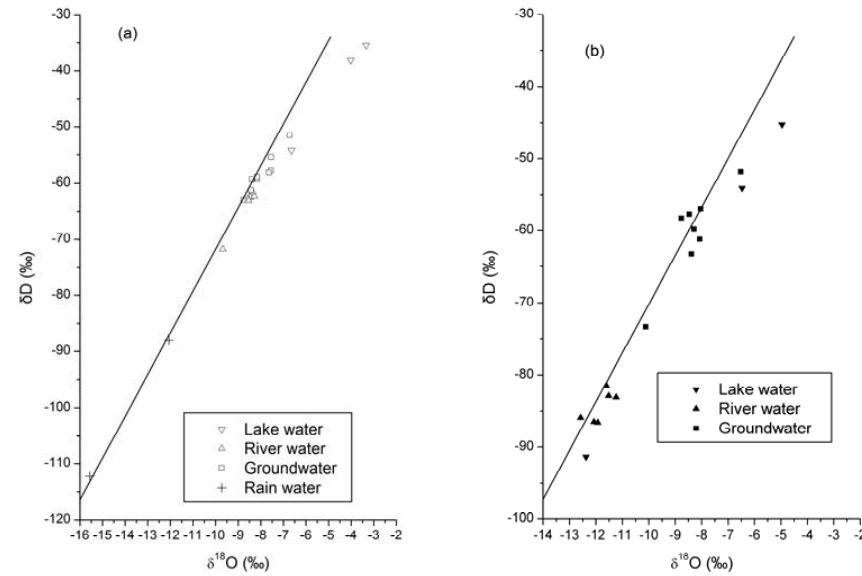
Fig. 6. Relationships between δ D and δ 18 O in water collected from JRB in July (a) and September (b) 2010.